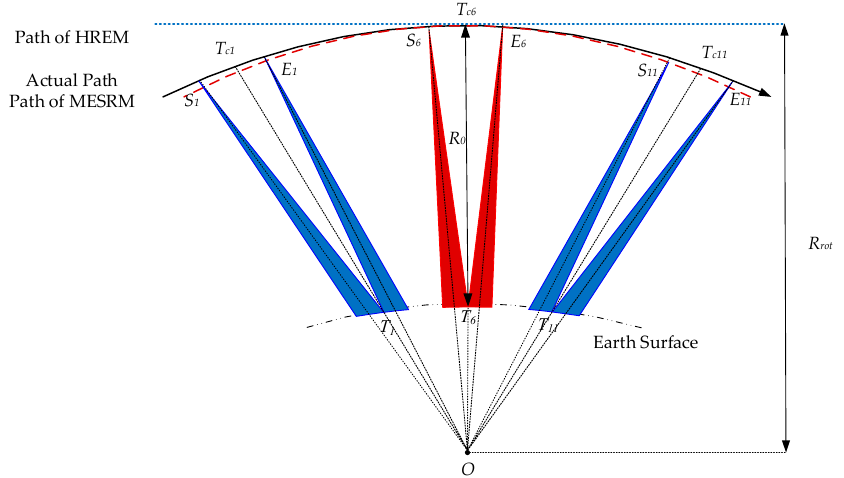
Figure 1. Geometric model of sliding spotlight mode for space-borne SAR.